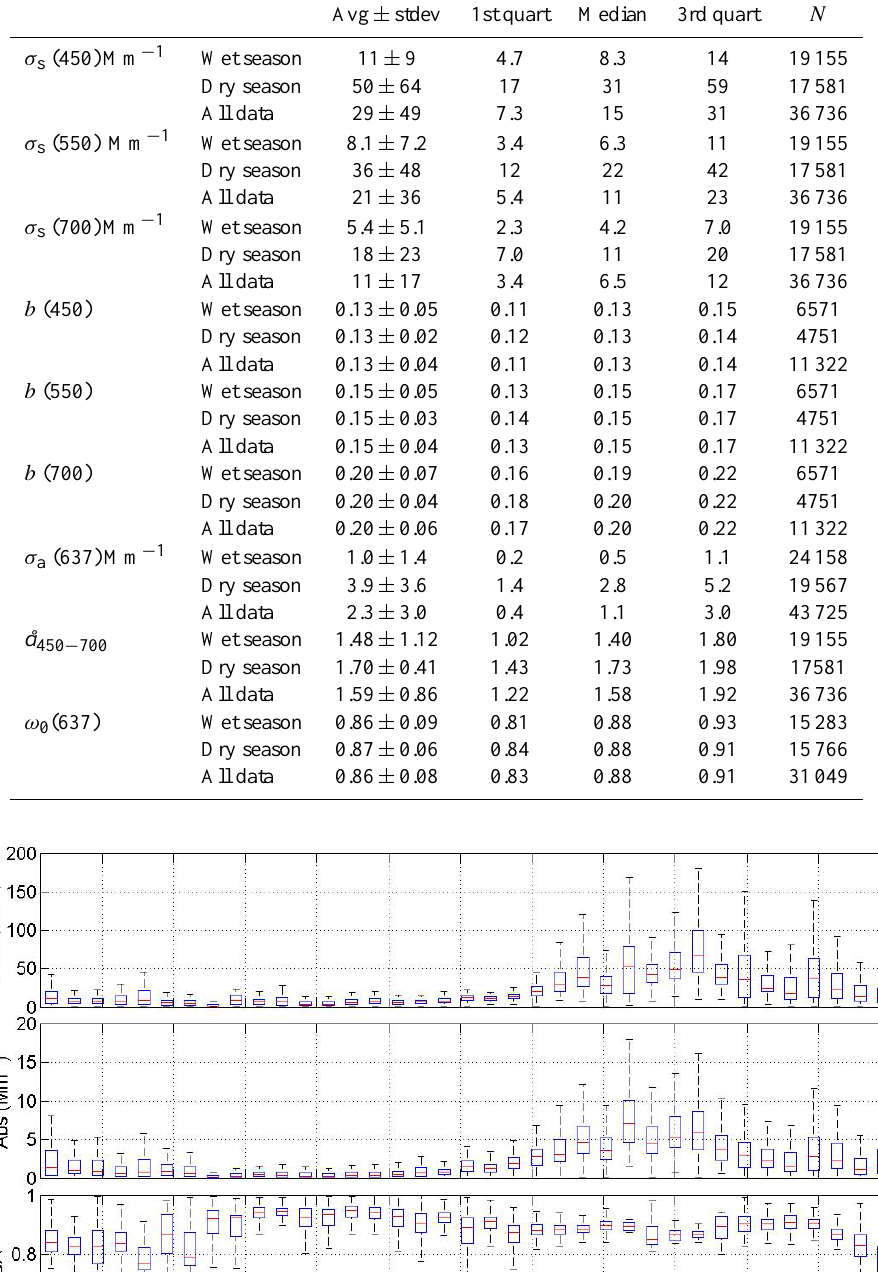
Table 6. Average, standard deviation, 1st quartile, median, 3rd quartile, and number of observations for aerosol particle scattering coefficients ( σ s ) and backscatter ratios ( b ) at 450, 550 and 700nm, absorption coefficients ( σ a ) at 637nm, ˚Angstr¨om exponent for scattering ( ˚a 450 − 700 ) and single scattering albedo at 637nm ( ω 0 ), based on 30 min averages.